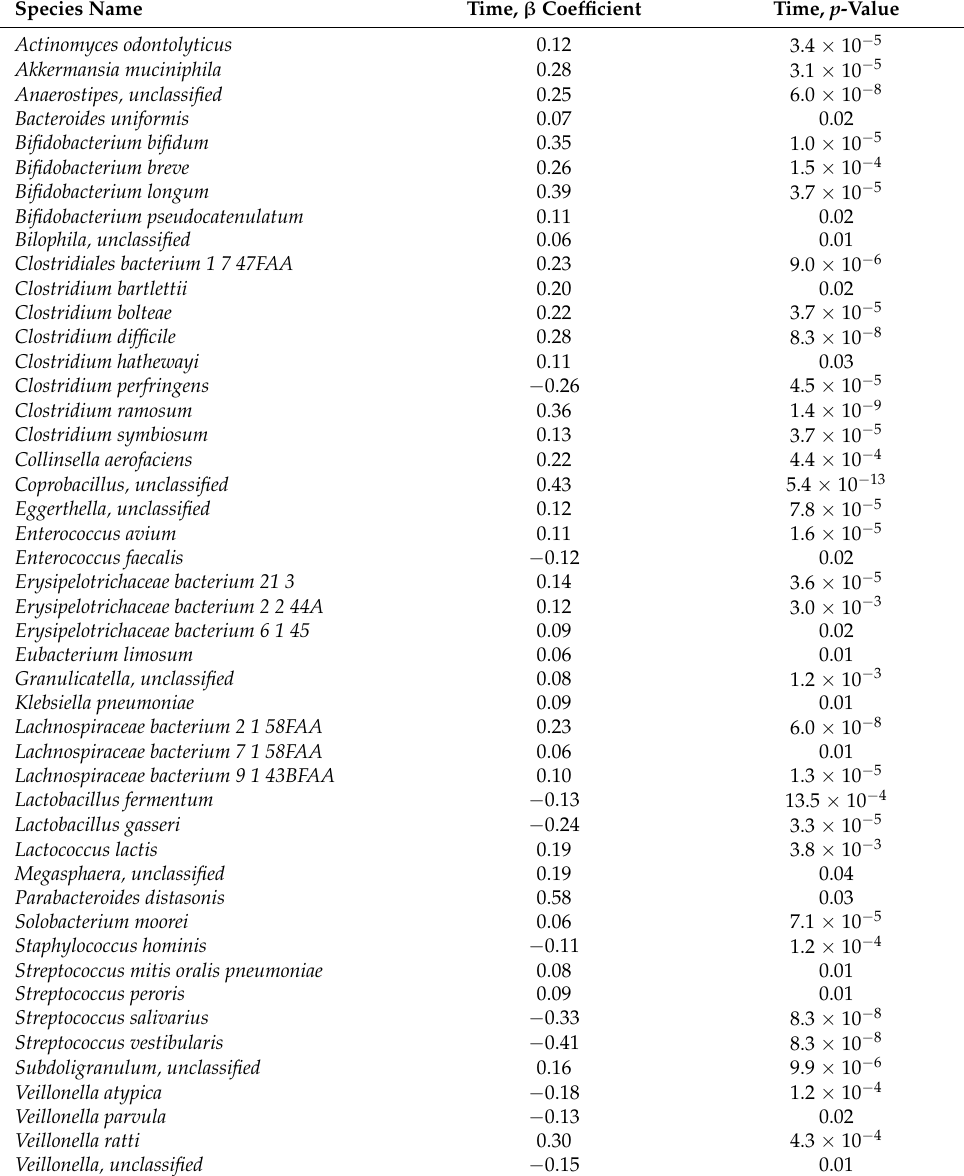
Table A1. Bacterial taxa (N = 47) with significant time effects 1 .